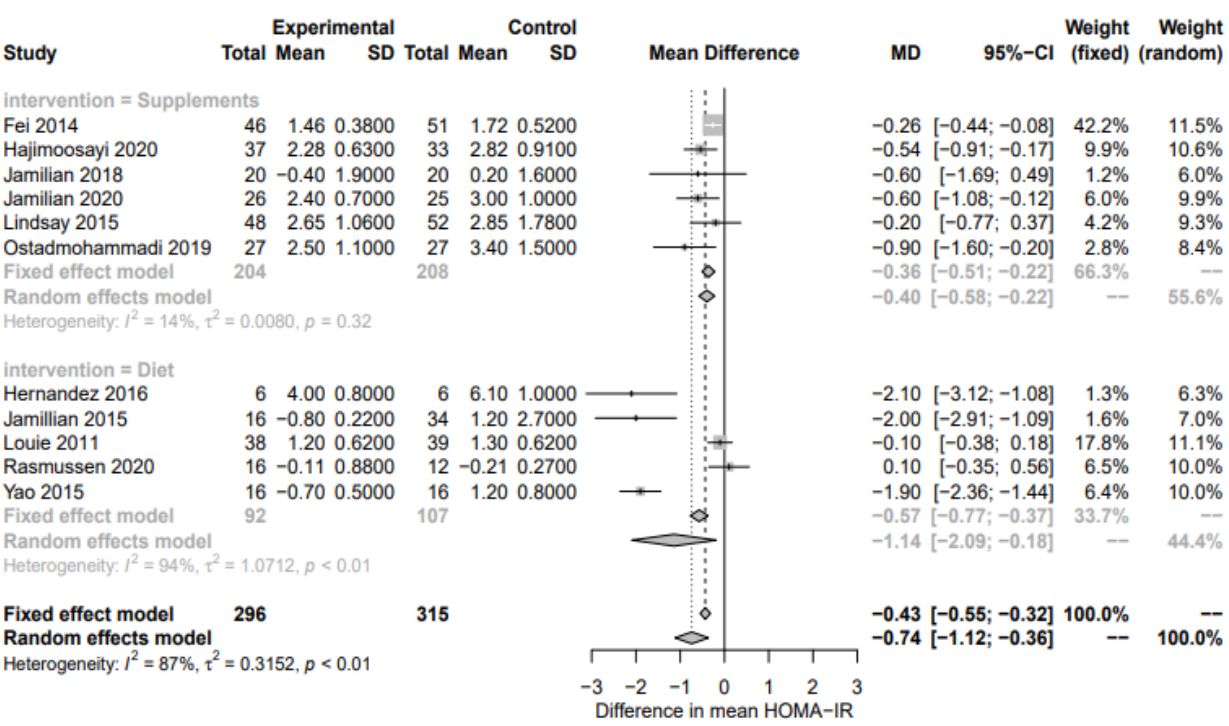
Figure 3. Forest plot of HOMA-IR. Fixed and random-effect meta-analysis of included studies. Overall test for effect of any lifestyle intervention (with all studies; n = 23) and subgroup analysis by intervention type—nutritional supplements (n = 8), diet (n = 10), and exercise (n = 5)—are presented. SD, standard deviation; CI, confidence interval.